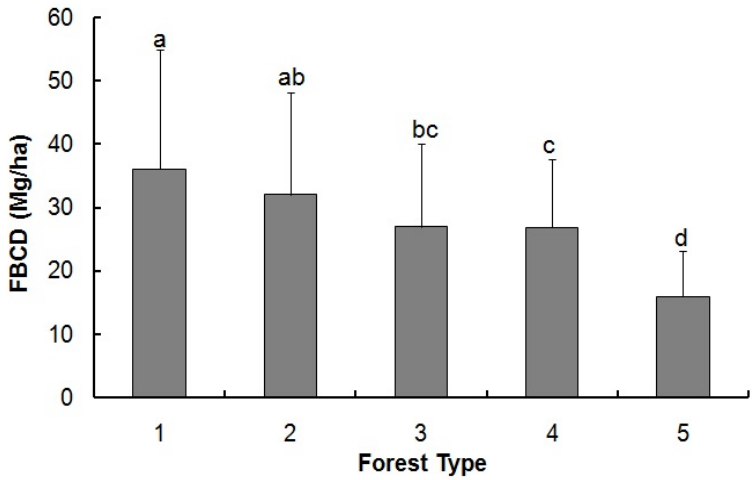
Figure 4. forest biomass carbon (FBC) density under typical forest types in Zhejiang province: (1) Broad-leaved forest; (2) Mixed coniferous broad-leaved forest; (3) Coniferous forest; (4) Moso bamboo forest; and (5) Economic forest. Different letters mean significantly different at 0.05